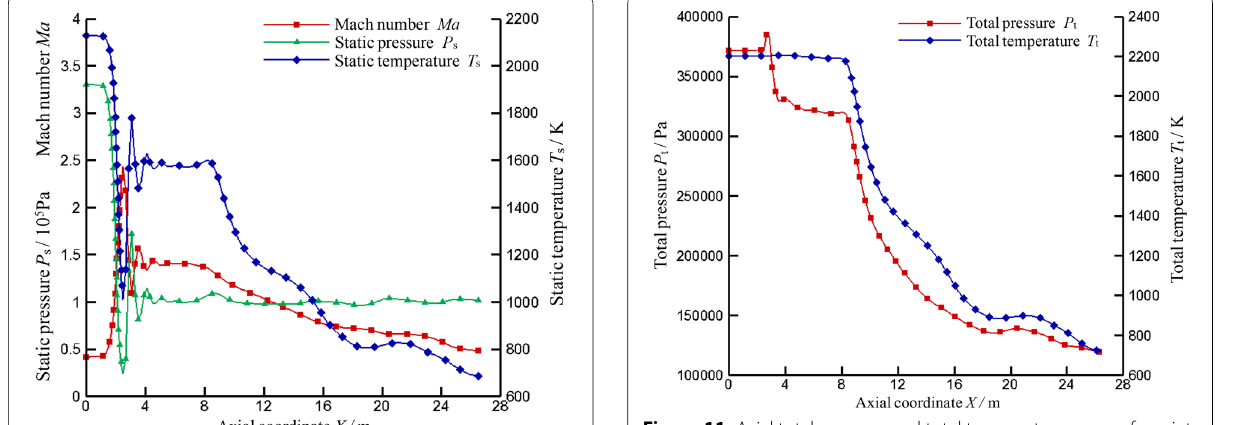
Figure 11 Axial total pressure and total temperature curve of gas jet from the aircraft engine